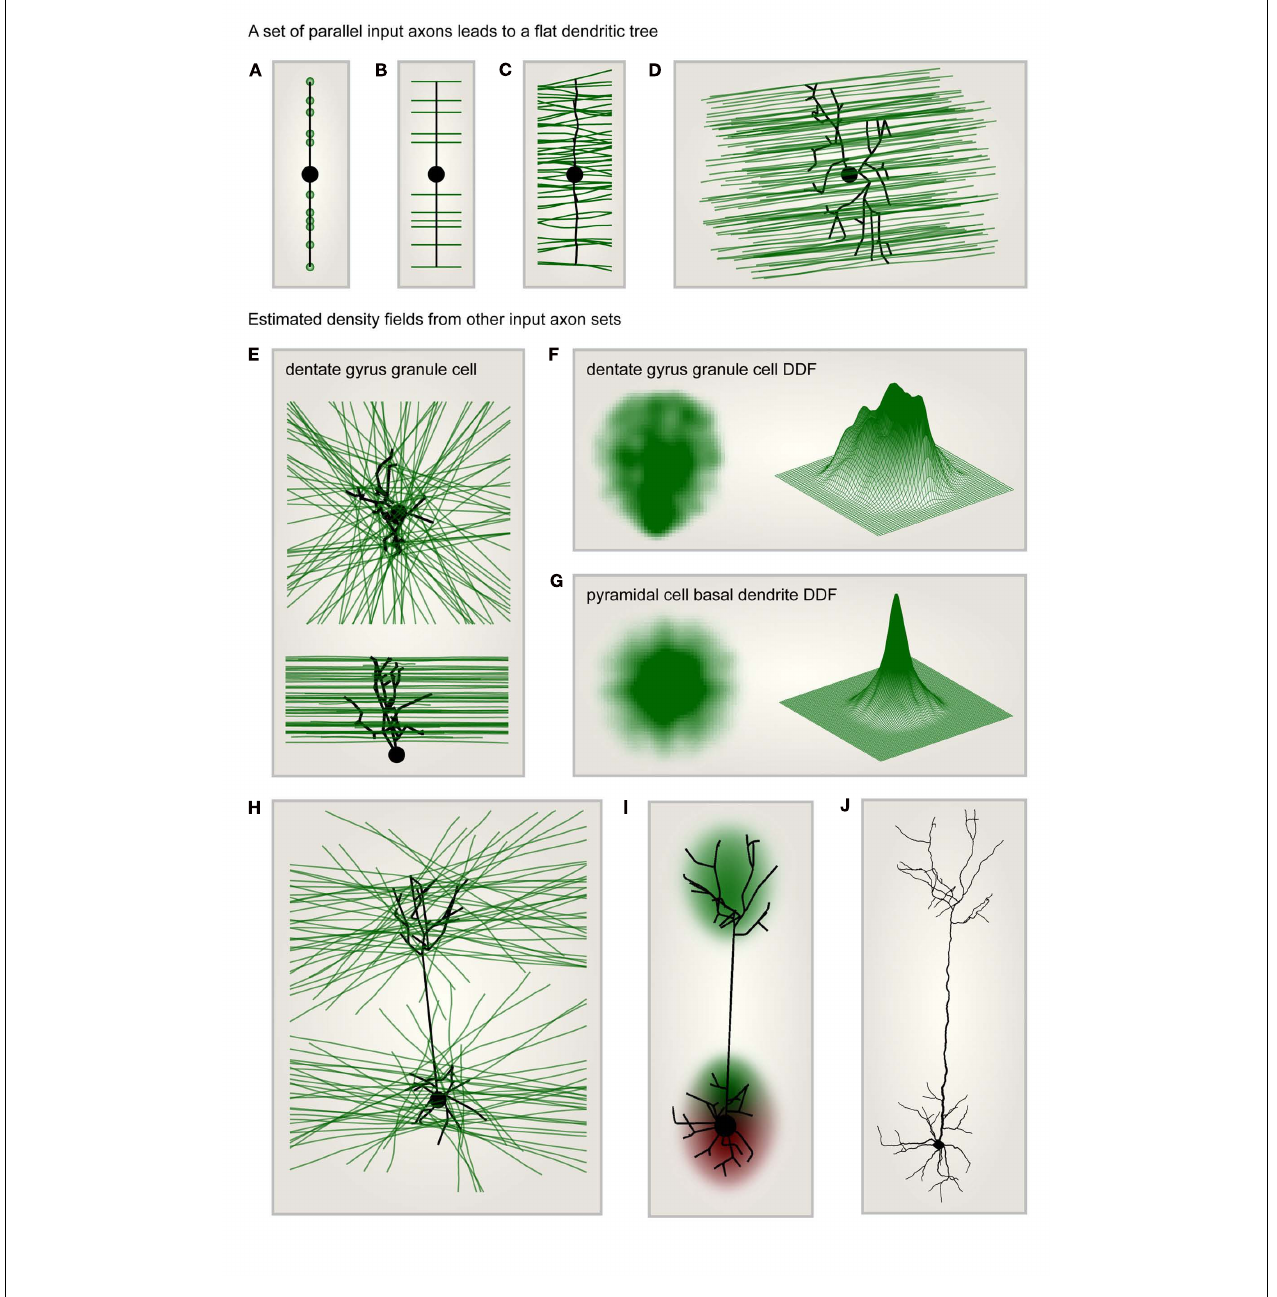
dot) located below the layer of axons.Top: view from the top; bottom: view from the side.The result is a typical dentate gyrus granule cell morphology. (F) DDF of 50 synthetic granule cells grown as in (E) ; compare with Figure 1C . Left: side view of density profile; right: mesh representation of the same density distribution. (G) Same as in (F) but the starting point was moved to the center of the layer to reproduce the characteristic shape of the basal tree of a cortical pyramidal cell. (H) Same as in (E) but the MST connects to axons located in two parallel layers.The starting point is located in the middle of the lower layer.The result is a characteristic pyramidal cell shape. (I) DDF of 100 synthetic pyramidal cells grown as in (H) ; compare with Figure 1D . (J) One such synthetic pyramidal cell where diameter values were mapped onto the dendritic segments and spatial jitter was added along the